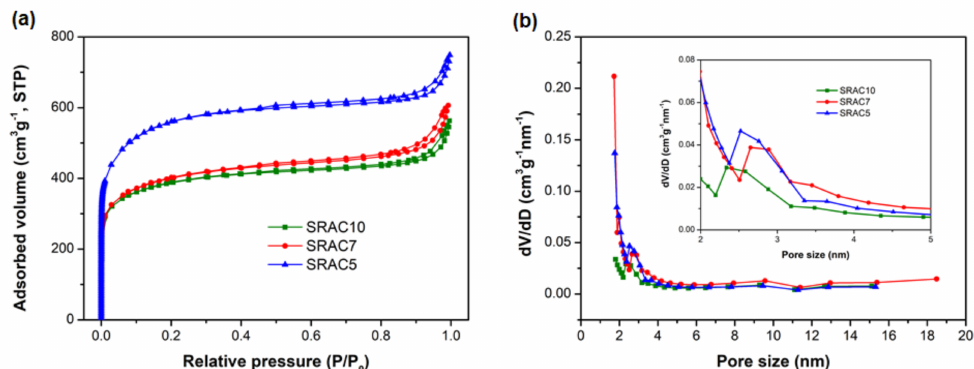
Figure 1. ( a ) Nitrogen adsorption–desorption isotherm curves; and ( b ) pore size distribution of